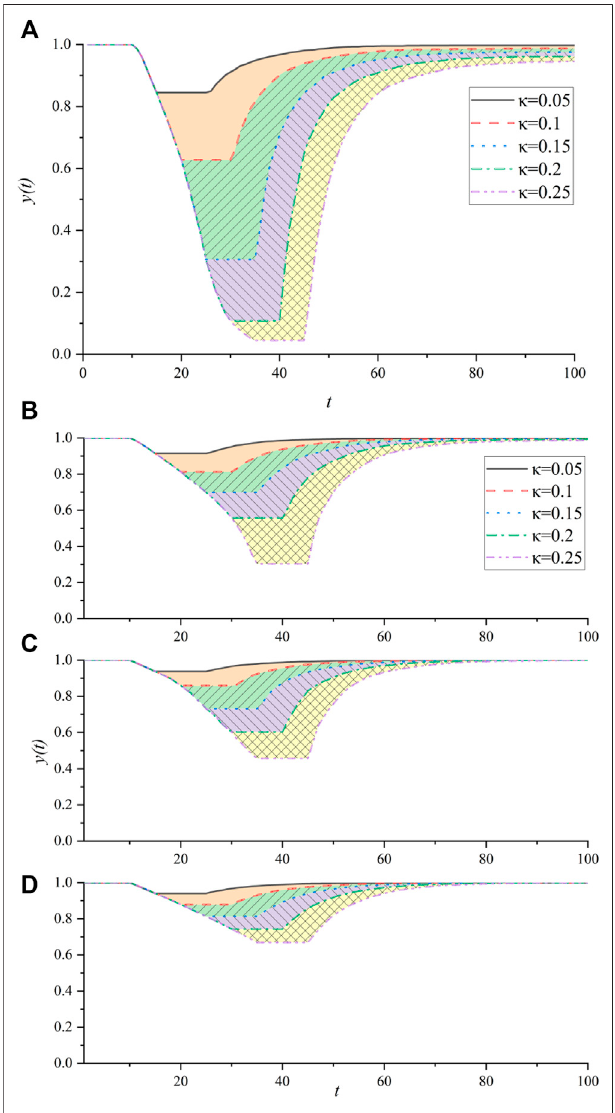
FIGURE 4 | Performance of UAV swarm under four topological structures. (A) BA network, (B) ER network, (C) NW network and (D) RR network. Each network was attacked fi ve times with varying intensity and repaired continuously. The attack mode and repair procedure are described in section 4.1